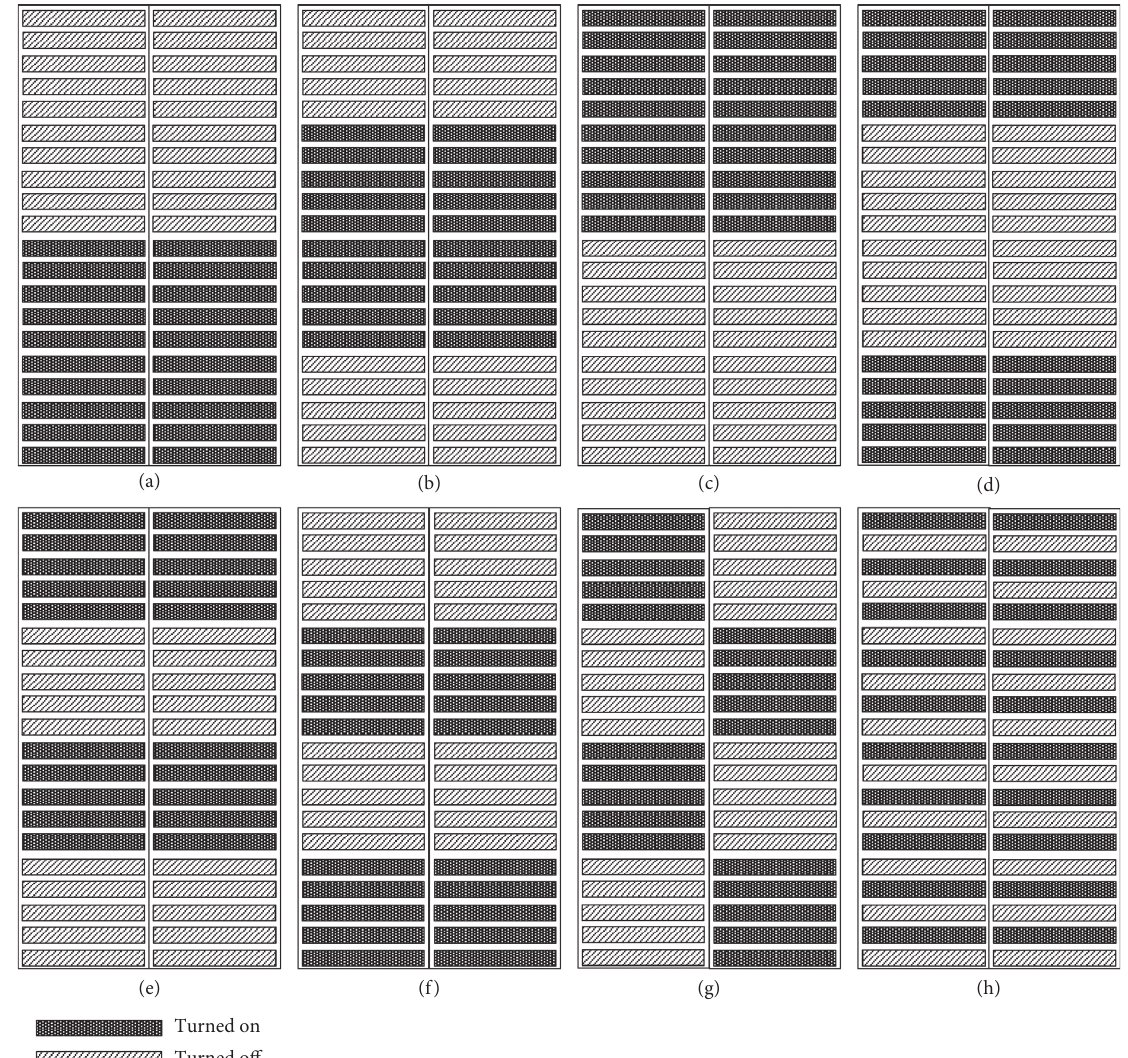
Figure 4: Schematic diagram of the workload allocation scheme. (a) Model 1. (b) Model 2. (c) Model 3. (d) Model 4. (e) Model 5. (f) Model 6. (g) Model 7. (h) Model